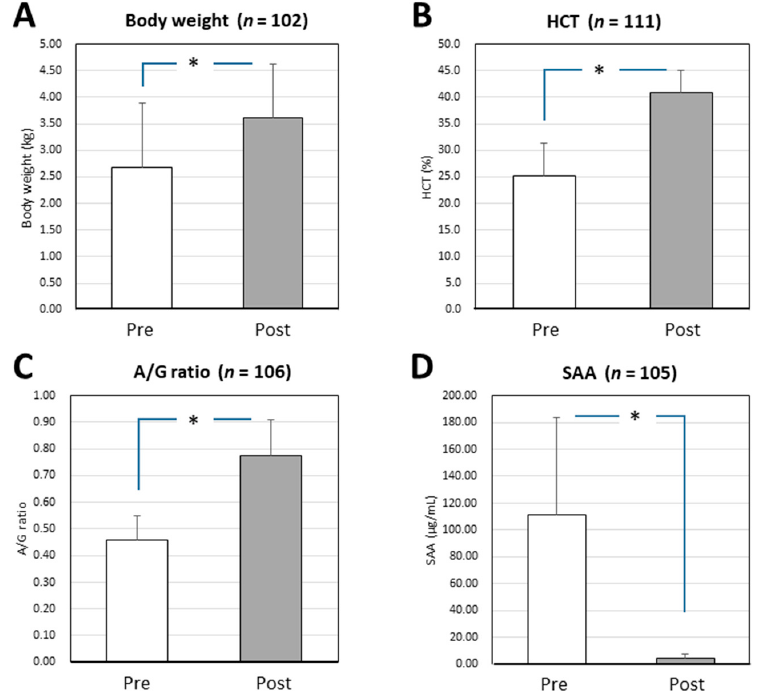
Figure 1. Changes in the parameters of surviving cats with effusive FIP before and after Mutian X treatment. The body weight ( A ), HCT ( B ), and A/G ratio ( C ) of the surviving cats were significantly improved after Mutian X therapy (Post) compared with their values at the initial examination prior to drug therapy (Pre) (* p < 0.0001). In contrast, SAA levels ( D ) were drastically decreased after therapy (* p < 0.0001). Means and standard deviations are indicated by open/shaded bars and vertical lines, respectively. All statistical analysis were performed using Wilcoxon signed-rank test (non-parametric). HCT, hematocrit; A/G, albumin-to-globulin ratio; SAA, serum amyloid-A.